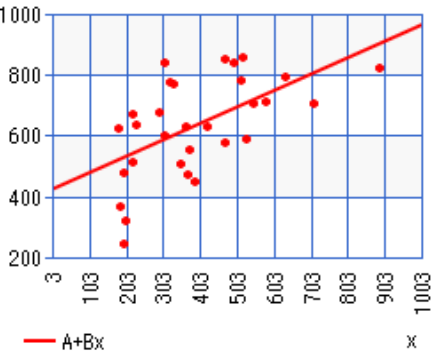
Figure 4. Linear regression for all participants and for all exergames. On the x-axe there are RG_SCORE obtained by all participants during S1 (first exergames session), RG_SCORE obtained during S9 (last exergames session) by all participants are on the y-axe.